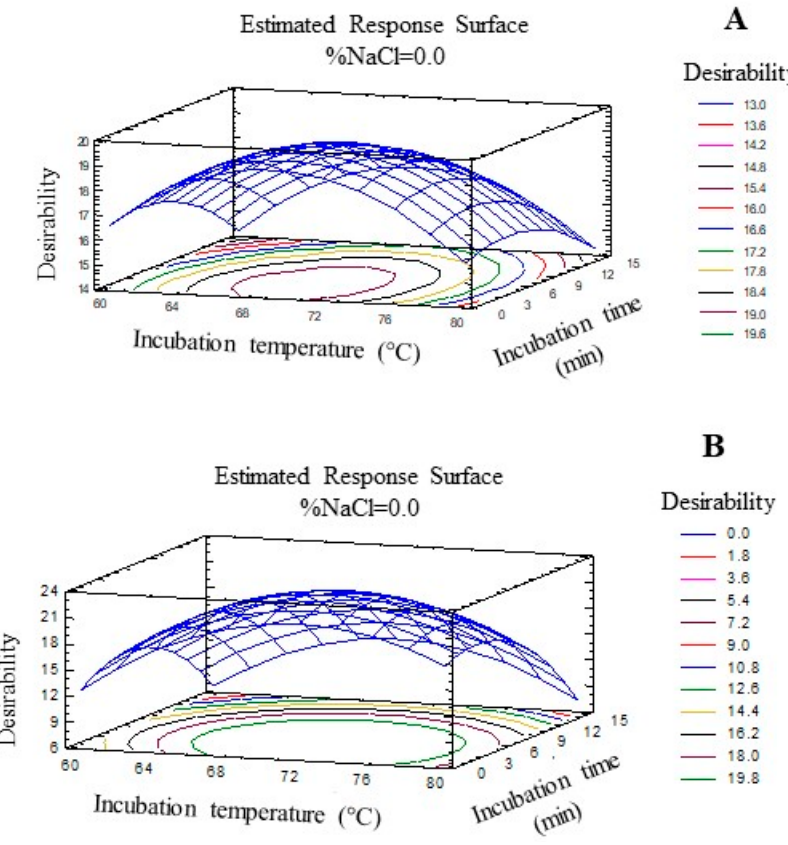
Figure 1. Estimated response surface for the study of the variables: %NaCl, temperature, and time of incubation, obtained by multiple response optimisation for serum ( A ) and urine ( B ) samples. After the multivariate study, the temperature of the drift tube was optimized between 60 and 90 ◦ C using a univariate method. Therefore, four experiments were performed, setting the temperature at 60, 70, 80, and 90 ◦ C using the previously optimized parameters for urine and serum. When comparing the sum of the areas of all markers for each of the tested drift tube temperatures for both serum and urine, the sum of signals increases continuously as the temperature increases. The best results were obtained using 90 ◦ C as the drift tube temperature.